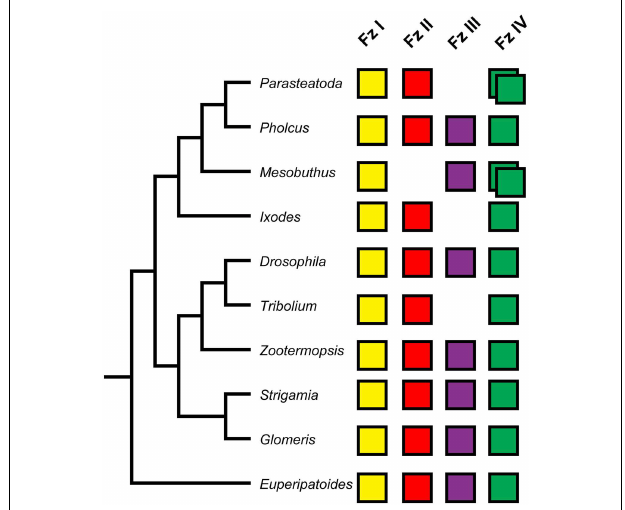
FIGURE 2 | Panarthropod frizzled genes. The four frizzled orthology groups are represented by colored boxes. The absence of a box indicates the loss of a particular frizzled ortholog. Duplicated frizzled genes are represented by two overlapping boxes. Phylogenetic relationships of the species included are indicated by the tree on the